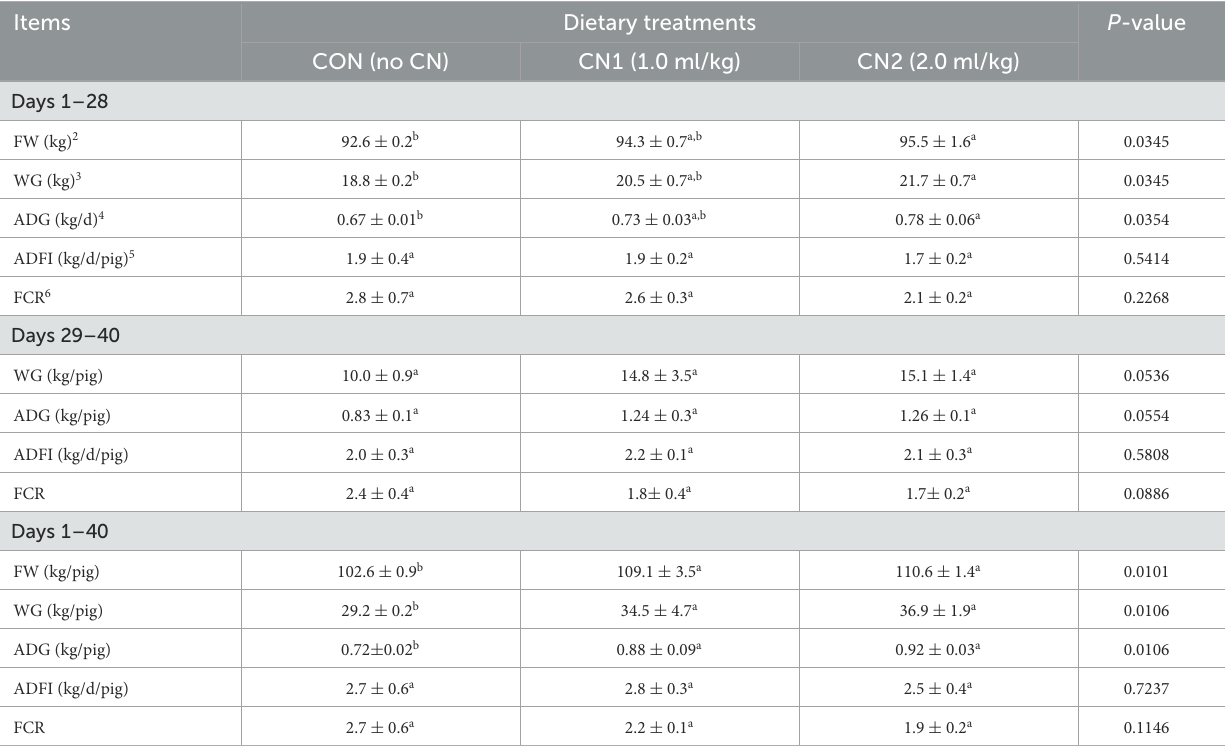
TABLE 1 Dietary curcumin nanospheres (CN) on performance and feed utilization in finishing pigs for 40 days 1